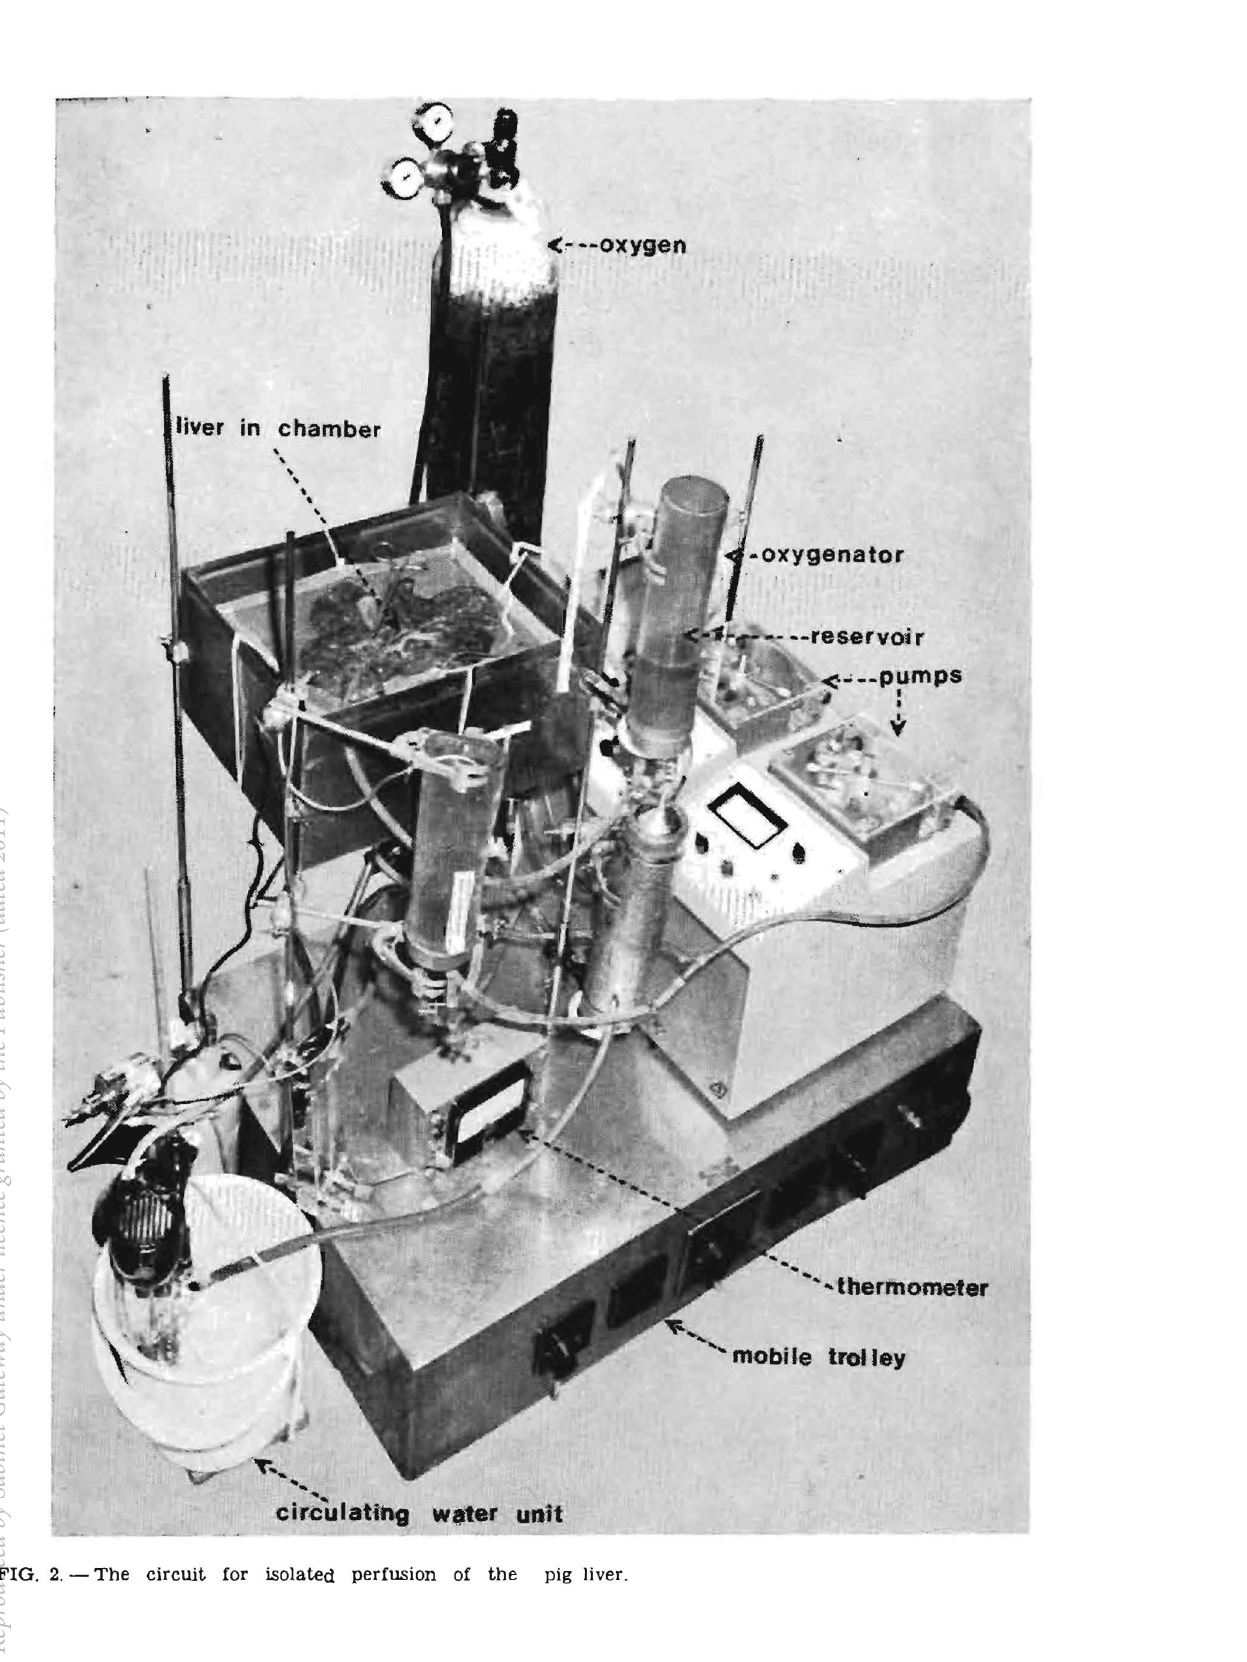
FIG. 2. - The circUit for isolated perfusion of the pig